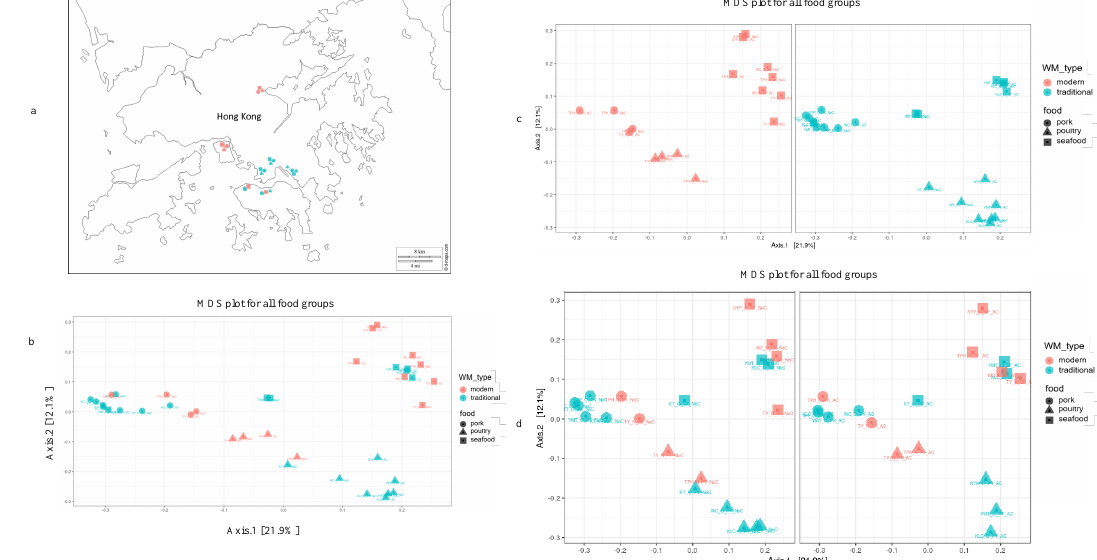
Figure 1. ( a ) Selected wet markets in Hong Kong based on their modern vs. traditional profiles; ( b ) Multidimensional scaling plot (MDS) of all samples from wooden cutting boards used for di ff erent food groups (pork, poultry, and seafood). ( c ) MDS plot for (i) modern wet market (left panel) and (ii) traditional wet market (right panel). ( d ) MDS plot for (i) uncleaned (left panel) and (ii) cleaned (right panel) cutting boards from di ff erent wet